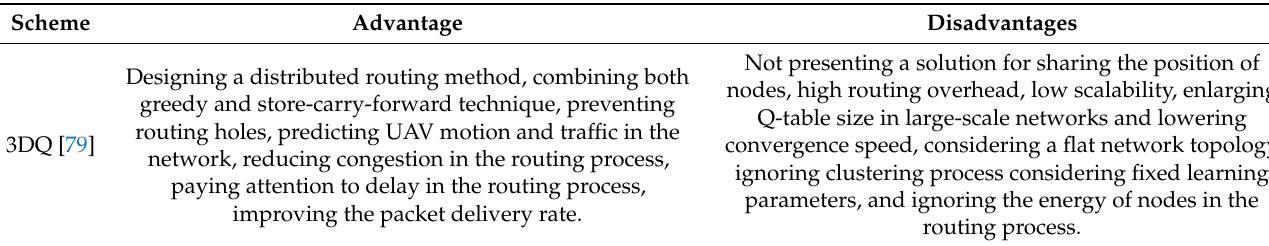
Figure 38. Learning process in 3DQ. Table 20. The most important advantages and disadvantages of